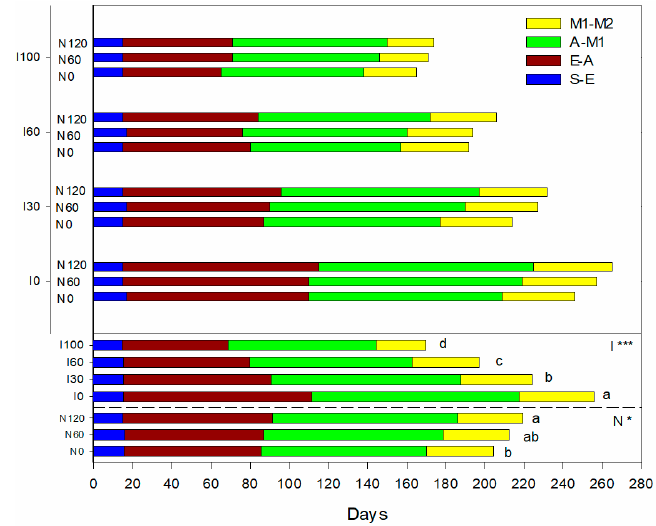
Figure 2. Length of phenological stages in castor (sowing–emergence (S-E), emergence–anthesis (E-A), anthesis–physiological maturation of the primary racemes (A-M1), and maturation of the primary racemes–maturation of secondary racemes (M1-M2)) in relation to irrigation (I0, I30, I60, and I100% = 0, 30, 60, 100% ETm restoration, respectively) and N fertilization (N0, N60, and N120 = 0, 60, and 120 kg ha − 1 of N, respectively). The lower part shows the mean separation of the total phenological stage length, with different letters representing statistically significant means according to the LSD test ( p ≤ 0.05). The significance levels of ANOVA for irrigation (*** significant at p ≤ 0.001) and N fertilization (* significant at p ≤ 0.05) are shown. The interaction I × N is not significant.